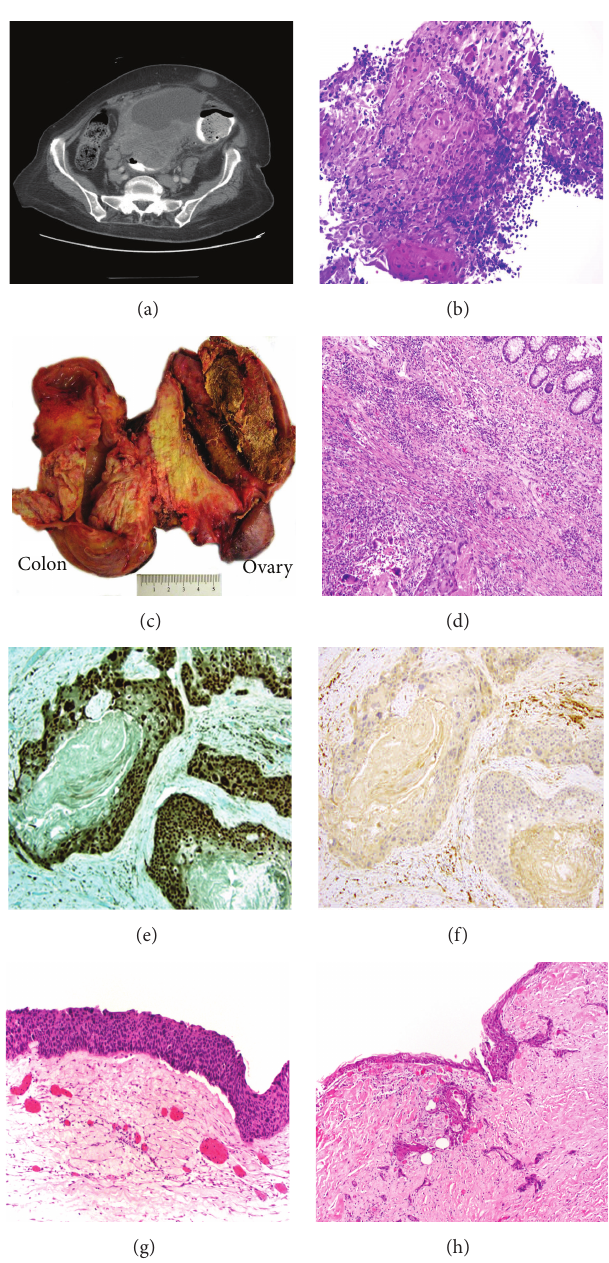
Figure 1: (a) Abdomen and pelvis CT showing a heterogenous mass with cystic and solid component. (b) Colon biopsy (H&E, 40x) showing a dysplastic squamous cell epithelium with keratin material, suspicious for squamous cell carcinoma. (c) Gross picture showing a cystic teratoma with sebaceous material and hair (right), the colon (left), and a firm white tan mass in between. (d) Squamous cell carcinoma (inferior left) invading into the colonic wall up to the submucosa (H&E, 20x). (e) P63 immunostain highlighting the tumor (20x). (f) Negative p16 immunostain (20x). (g) In situ squamous cell carcinoma (H&E 20x). (h) In situ squamous cell carcinoma with invasive component (H&E,